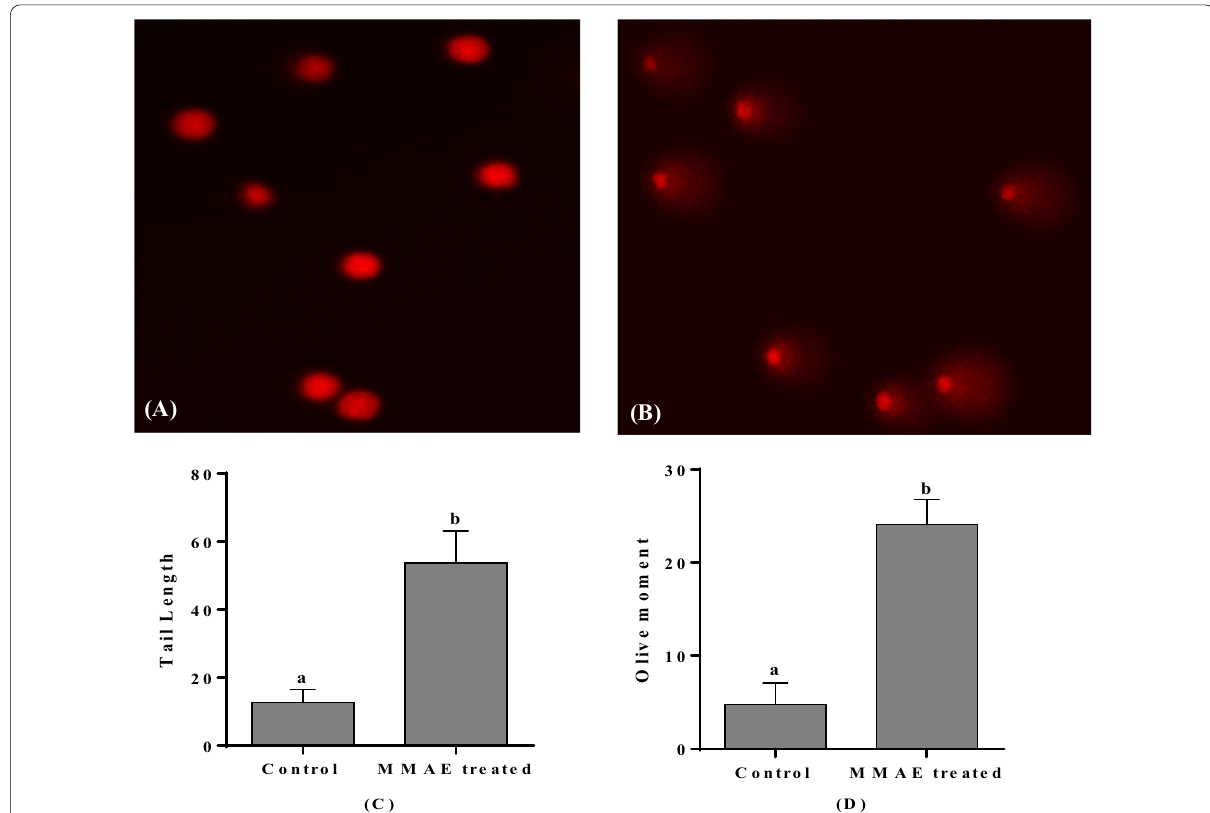
Fig. 3 Fluorescence images of Comets observed in control ( A ) and MMAE treated ( B ), and the extent of DNA damage expressed in terms of Tail length ( C ) and Olive moment ( D ). Control: DLA bearing mice without treatment. MMAE treated: DLA bearing mice treated with 100 mg/kg of aqueous extract of M. macrophylla . Different letters indicate significant variation at p <